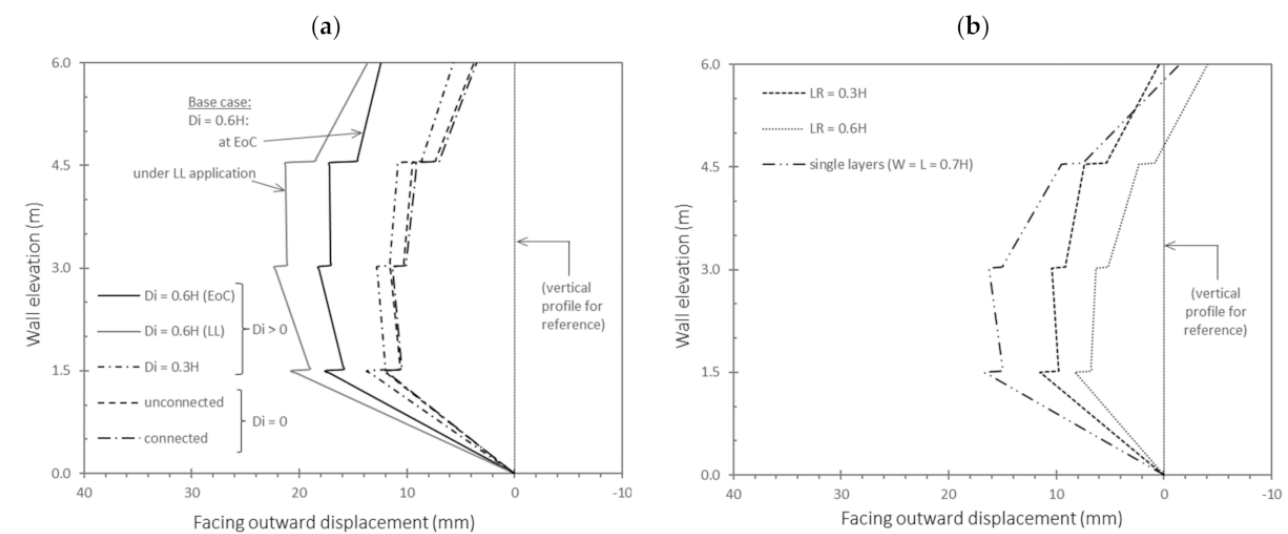
Figure 7. Facing displacements at the end of construction (EoC) for different interaction distances ( D i ) between the back of the reinforced soil zone for opposite walls: ( a ) D i > 0 and D i = 0, and ( b ) D i <